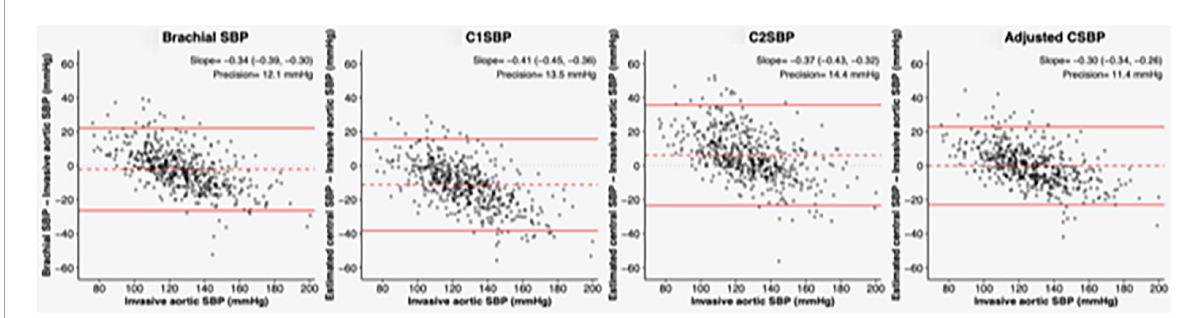
FIGURE4 Bland–Altman plots for aortic SBP before and after adjustment. Modified Bland–Altman plots show the reference intra-arterial measurements (aortic SBP) on the X -axis instead of the mean of both measurements. Left to right panels show in order the agreement of brachial cuff SBP, C1SBP, and C2SBP with aortic SBP. All values are in mmHg. Red dashed lines and red solid lines represent mean differences (bias) and limits of agreement (bias ± 2 SDs) respectively. C1SBP, Type I central systolic blood pressure; C2SBP, Type II systolic blood pressure; SBP, systolic